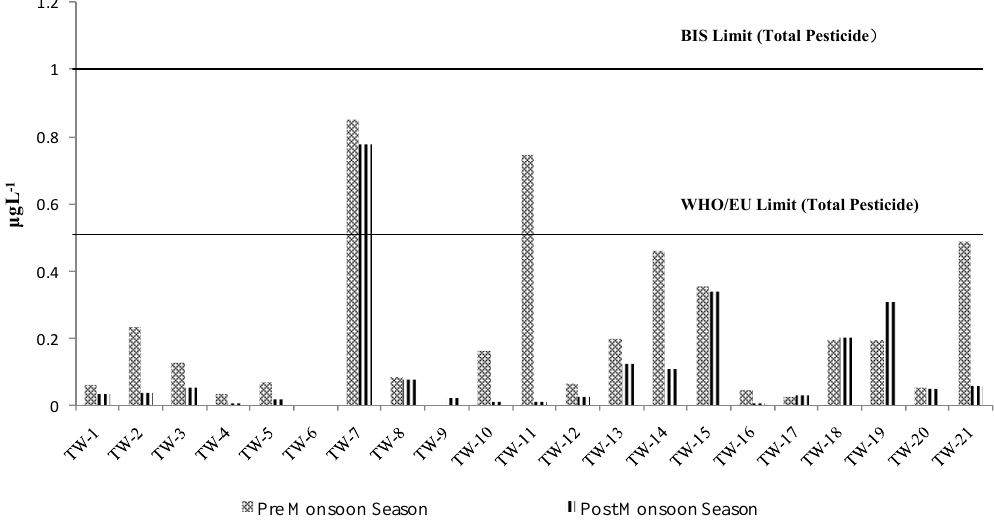
Figure 7. Comparison of borewell water quality with respect to various limits